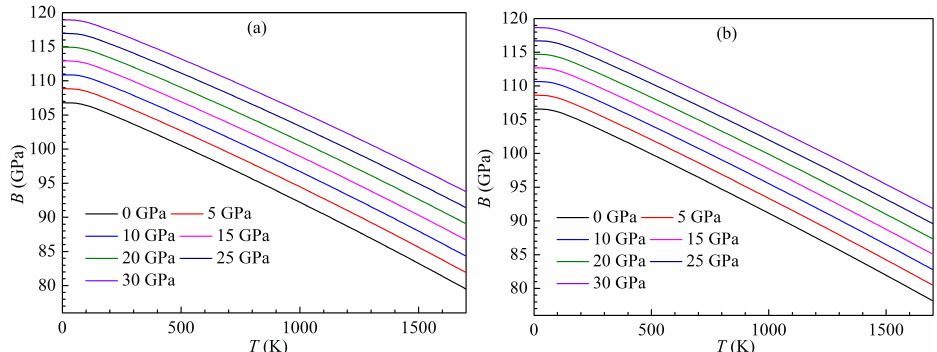
Figure 15. Temperature dependence of bulk modulus B for the LPSs ( a ) h- and ( b ) r-Al 2 Ti under pressure up to 30 GPa.